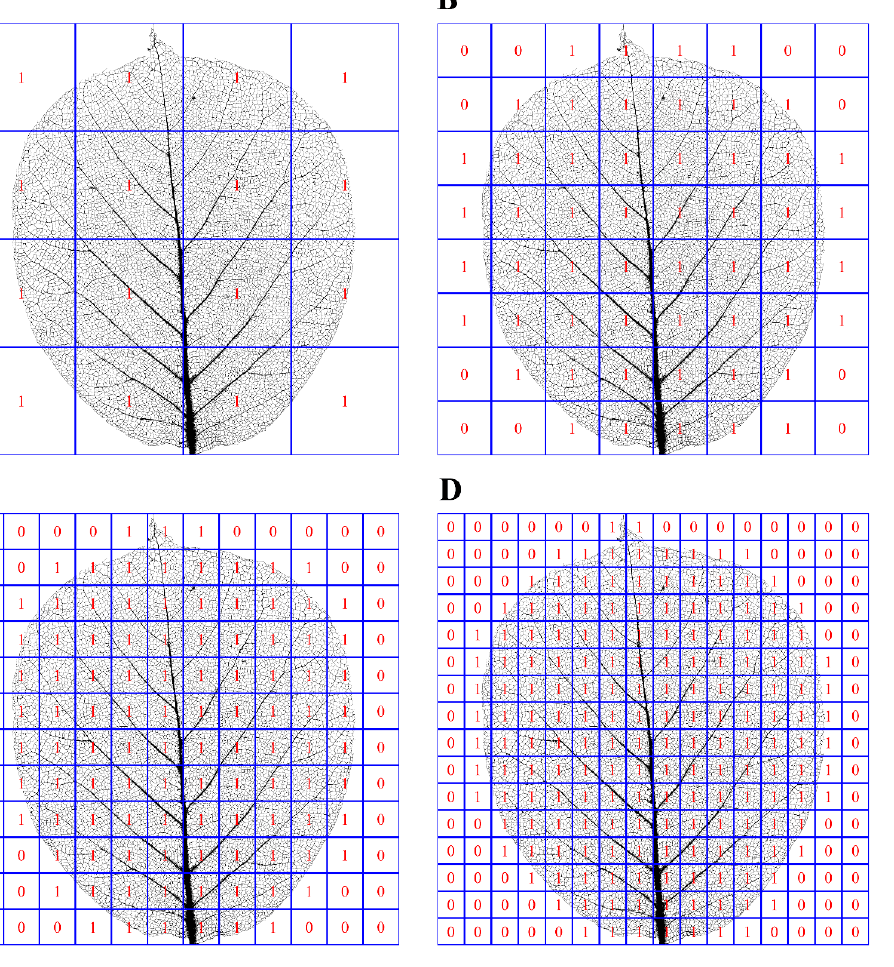
Figure 2. A leaf shape example of Magnolia denudata Desr. for counting the number of boxes that at least include a leaf vein pixel (which were marked with 1). The x -range of leaf vein pixels is 9.99 cm, and the y -range of leaf vein pixels is 11.42 cm. Let us define the maximum between the two ranges as z , so z = 11.42 cm. Panels ( A − D ) represent that box size (i.e., the length of the side of the square, represented by δ ) = z /4, z /8, z /12, and z /16, respectively. The corresponding numbers of boxes that at least include a leaf vein pixel are 16, 53, 104, and 179, respectively. In actual calculations, δ was set to range from z /20, z /19, z /18, …, to z /2 points to estimate the slope of the linear equation of ln( N ) vs. ln( δ ). In this range, the linear trends are all apparent for all leaves investigated.